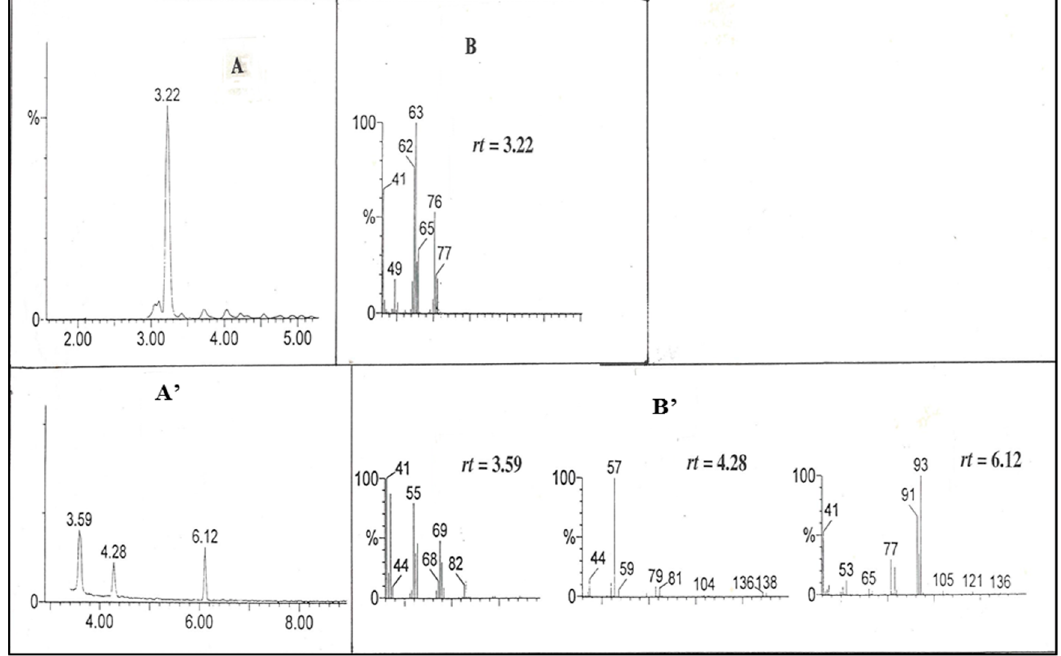
Figure 7. ( A,A’ ) Gas chromatograms and ( B,B’ ) mass spectra of different systems: ( A,B ) pure AC (allyl chloride); ( A’,B’ ) AC degradation products from constant-potential bulk electrolysis using a carbon plate cathode of 5 mM ally chloride + 1 mM [Co(II)(bpy) 3 ] 2+ + 100 mM BKC in a 0.1 M Na 2 SO 4 aqueous solution. Potential applied = − 1300 mV (SCE). Mass spectra are given for different retention times ( rt ) indicated in the figure.